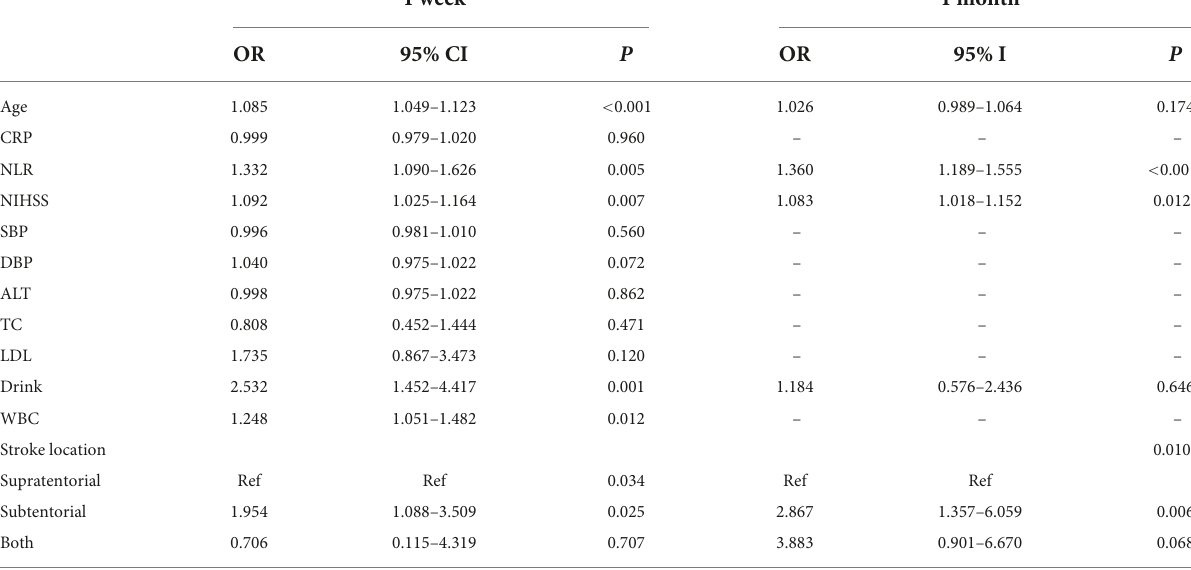
TABLE 2 Univariate analysis for the potential factors associated with indwelling nasogastric tube by logistic